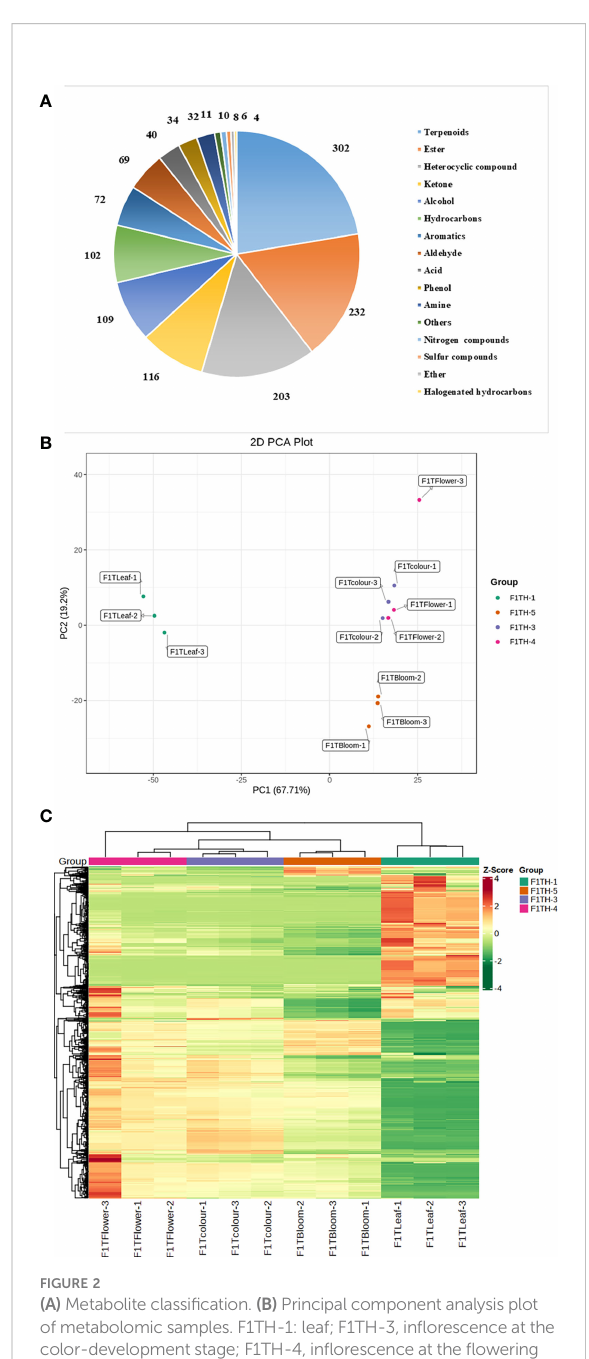
FIGURE 2 (A) Metabolite classi fi cation. (B) Principal component analysis plot of metabolomic samples. F1TH-1: leaf;F1TH-3,in fl orescenceat the color-development stage; F1TH-4, in fl orescence at the fl owering stage; F1TH-5,in fl orescenceat the full-bloomstage. (C) Cluster analysis of metabolomic